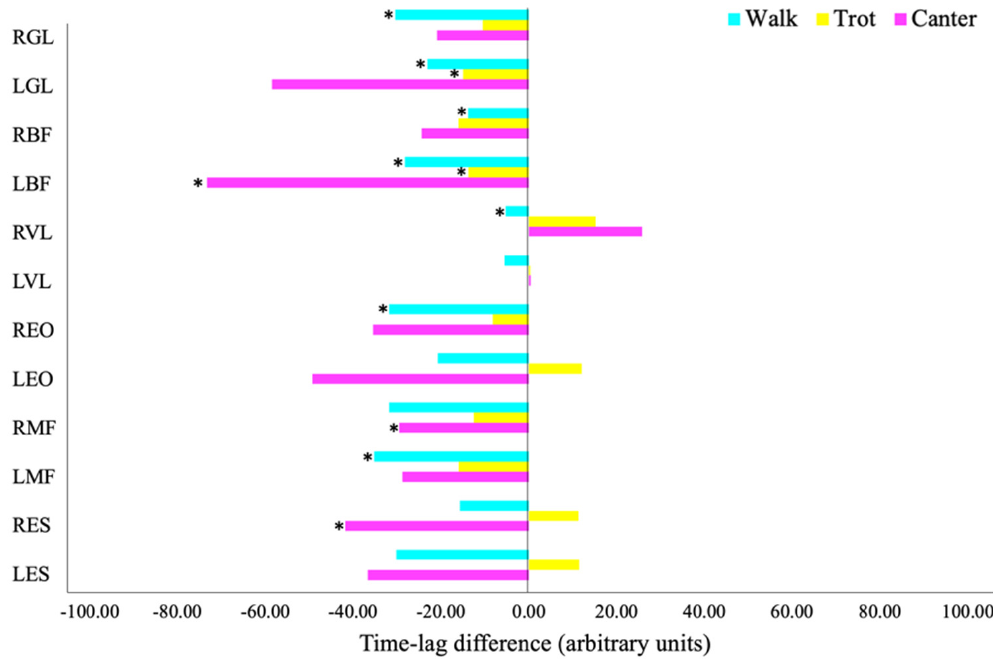
Figure 4. Differences in time lag at peak correlation. Negative values correspond to a lower time lag of the advanced group, while positive values correspond to the opposite. *Significantly different between groups ( p < 0.05).